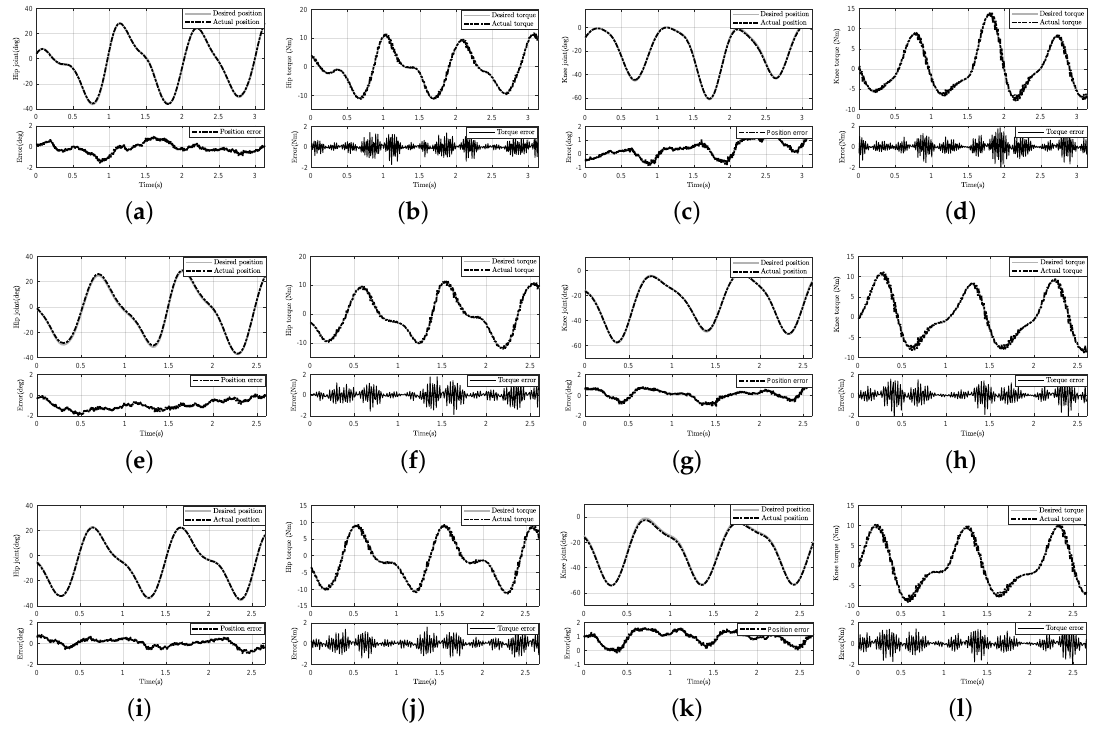
Figure 16. Experiment with the other three human subjects during the swing phase of normal locomotion. The results of three human subjects (B, C, D) are presented in order from the first row to the third row. ( a ) Hip joint tracking and corresponding tracking error of human subject B; ( b ) desired torque and actual torque of hip joint of human subject B; ( c ) knee joint tracking and corresponding tracking error of human subject B; ( d ) desired torque and actual torque of knee joint of human subject B; ( e ) hip joint tracking and corresponding tracking error of human subject C; ( f ) desired torque and actual torque of hip joint of human subject C; ( g ) knee joint tracking and corresponding tracking error of human subject C; ( h ) desired torque and actual torque of knee joint of human subject C; ( i ) hip joint tracking and corresponding tracking error of human subject D; ( j ) desired torque and actual torque of hip joint of human subject D; ( k ) knee joint tracking and corresponding tracking error of human subject D; ( l ) desired torque and actual torque of knee joint of human subject